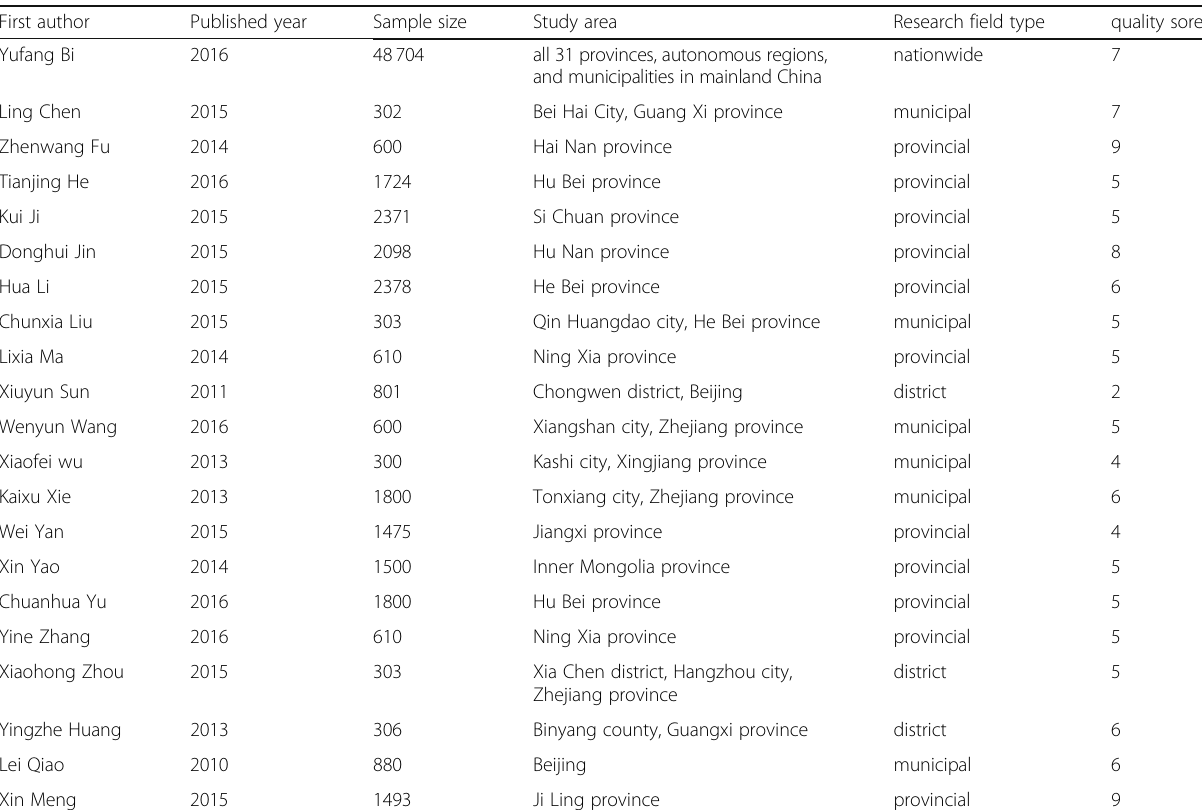
Table 1 Quality evaluation of the included literature